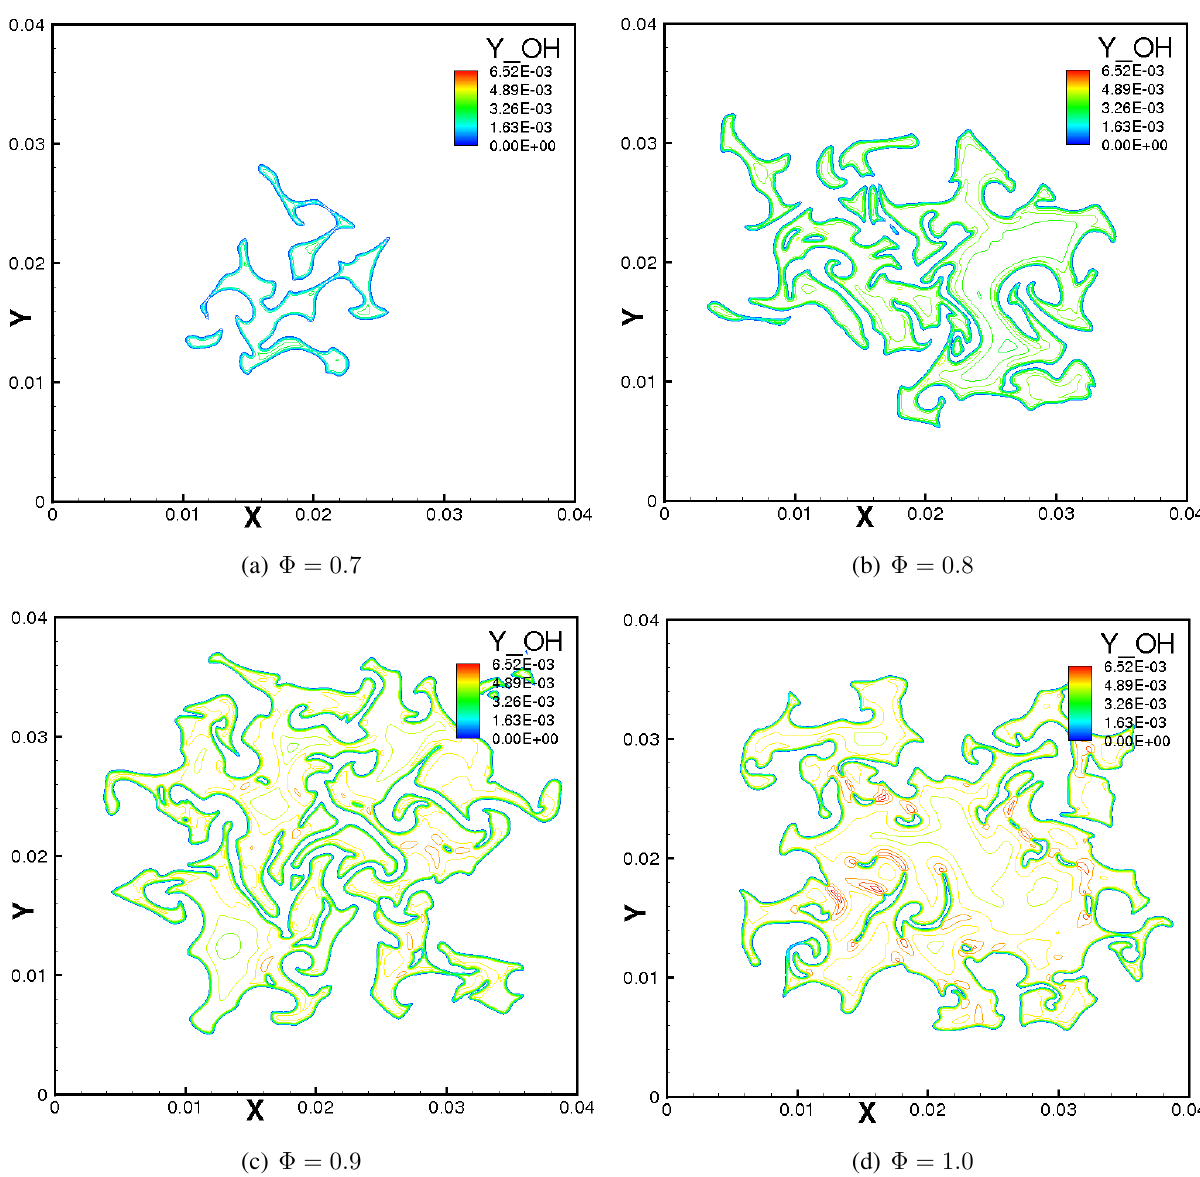
Figure 5. Instantaneous iso-contours of the mass fraction of OH ( case 6 , Re different mixture equivalence ratios Φ at the same time t = 1 . 3 τ